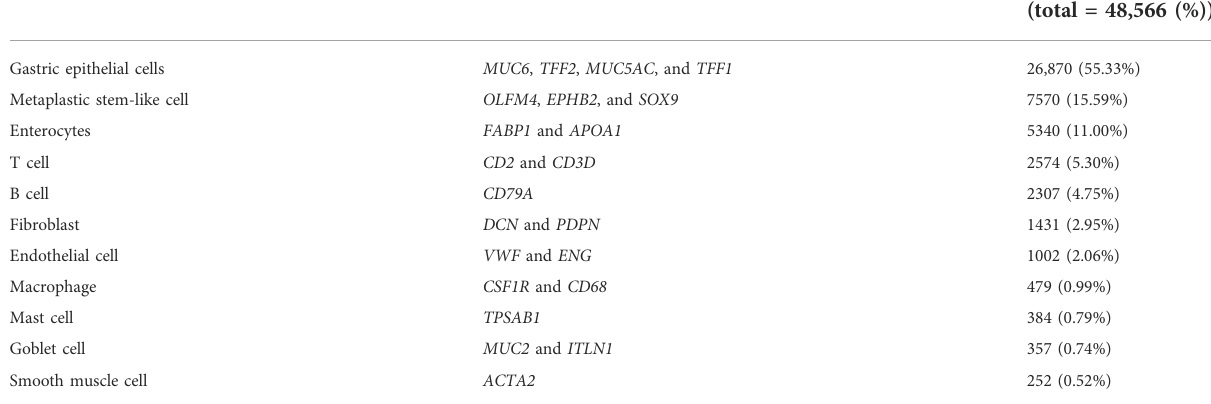
TABLE 1 Cell types of 25